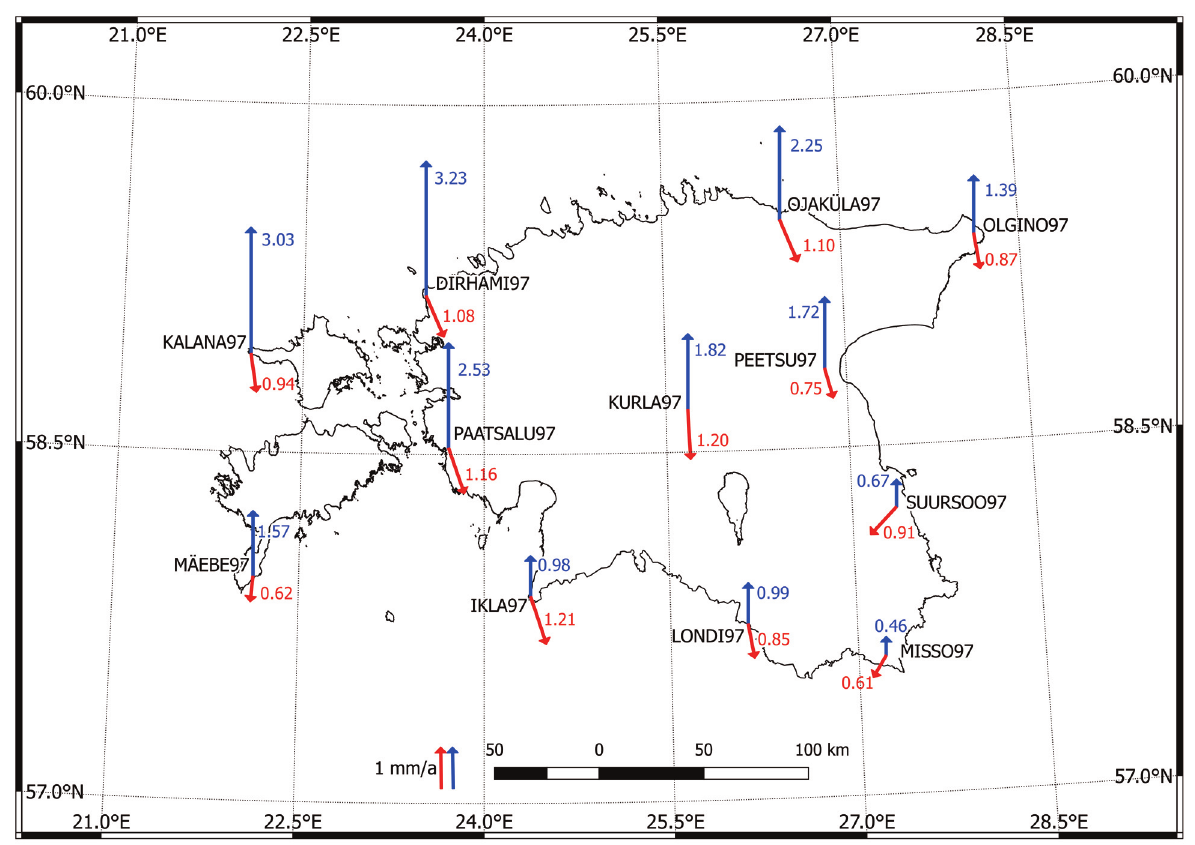
Fig. 5. The intraplate velocities ( ν obs – ν ITRF 2008– PMM ) of the GRN points in horizontal (red) and vertical (blue) directions, according to Kruusla (2019). Units